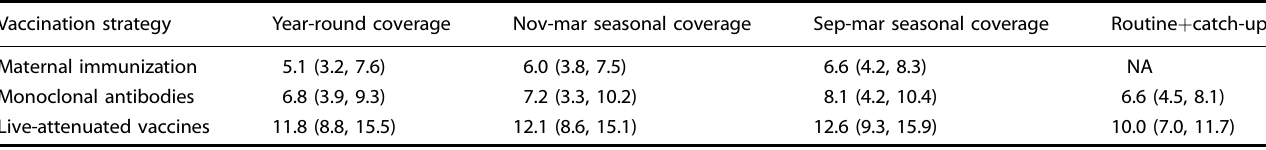
Table 3. Per-dose effectiveness estimates for year-round and seasonal intervention